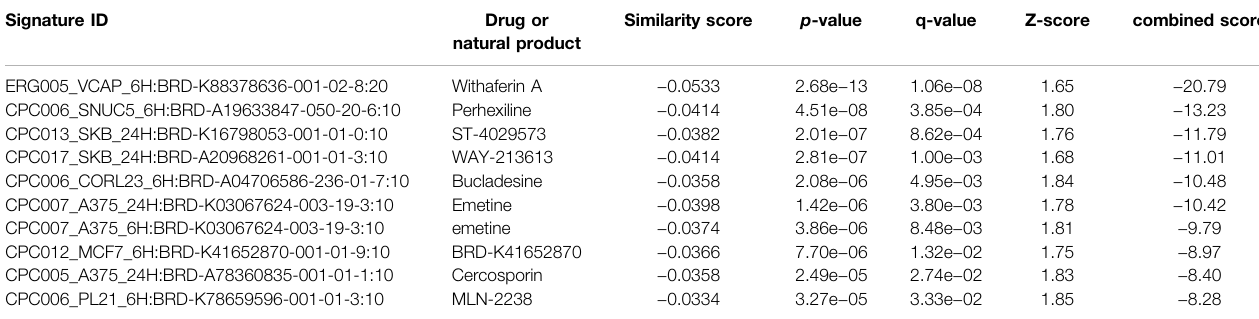
TABLE 9 | Top small molecules with opposite molecular signatures based on L1000FWD web-based tool for querying gene expression signatures (Neuro-COVID vs. IIH-monoMeta) against signatures created from human cell lines treated with over 20,000 small molecules and drugs for the LINCS